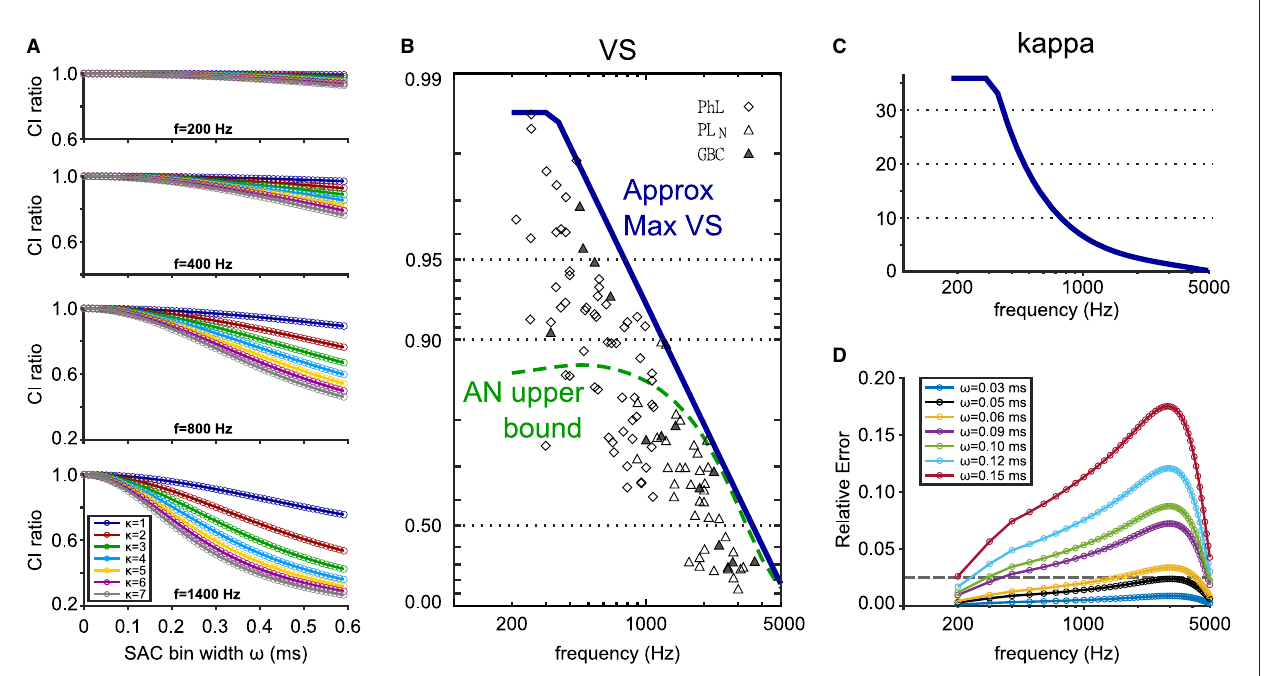
FIGURE 8 | Estimation of the binning error in CI calculation depending on the bin size ω , frequency f , and concentration parameter κ . (A) Theoretical CI decay (see Equation 7) for four different frequencies and seven different κ values. CI ratio was calculated as CI ω / CI. (B) Empirical VS values measured in cats and their maximum values approximated by a function VS max = min { 0.986,1 − ( f / 5700) 1.5 } . Symbols show cat TB fiber recordings ( Joris et al., 1994). Diamonds: phase-locked units; open triangles: presumed GBCs with primary-like-with-notch PSTHs; filled triangles: histologically confirmed GBCs. Dashed green line indicates the maximal VS values for cat AN fibers (Johnson, 1980). Figure adapted from Ashida et al. (2019). (C) Estimation of κ max from VS max in (B) calculated with Equation (3). (D) Upper CI error bounds for different bin widths calculated with the estimated κ max shown in (C) . Relative errors were computed as (CI − CI ω ) / CI. The gray dotted horizontal line highlights the relative error of 2.5